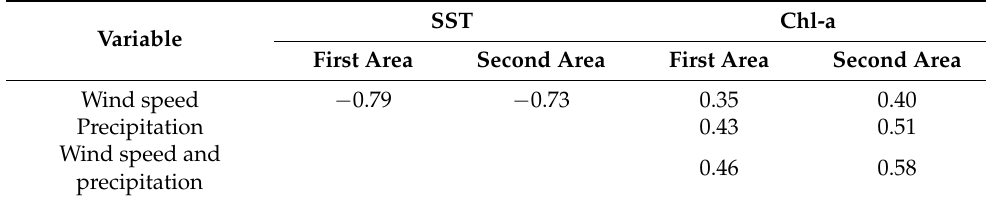
Table 1. Significant correlation analysis ( p < 0.05) among SST, Chl-a, wind speed, and precipitation from